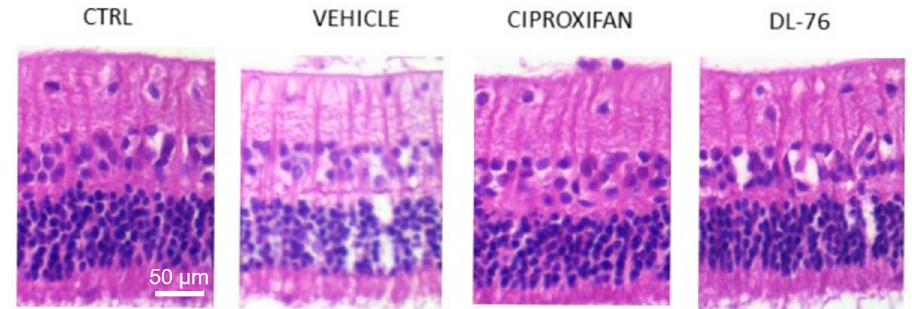
Figure 3. Representative images of hematoxylin/eosin-stained histological sections of retinae from different treated groups. RGCs are visible in the upper layer. The histological sections of Vehicle, Ciproxifan and DL-76 panels were prepared from carbomer-induced glaucoma models in male NZW rabbits with stable elevated IOP [60] modified.